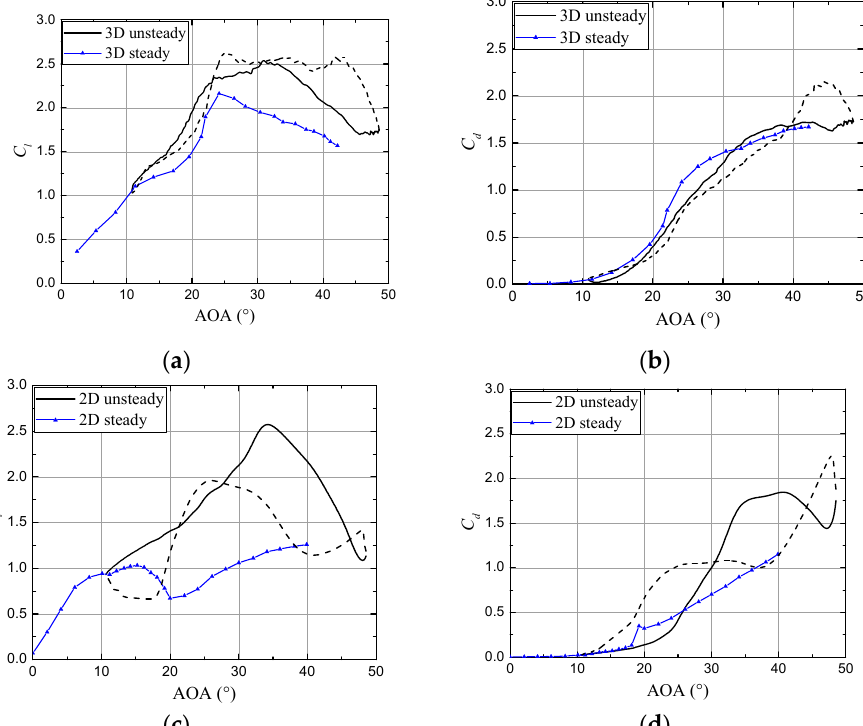
Figure 9. Hysteresis loops of the lift and drag coefficients. r / R = 30%, V w = 15 m/s, and ϕ y = 30°. Solid lines denote increasing AOA, and dashed lines decreasing AOA. ( a ) 3D C l ; ( b ) 3D C d ; ( c ) 2D C l ; ( d ) 2D C d .